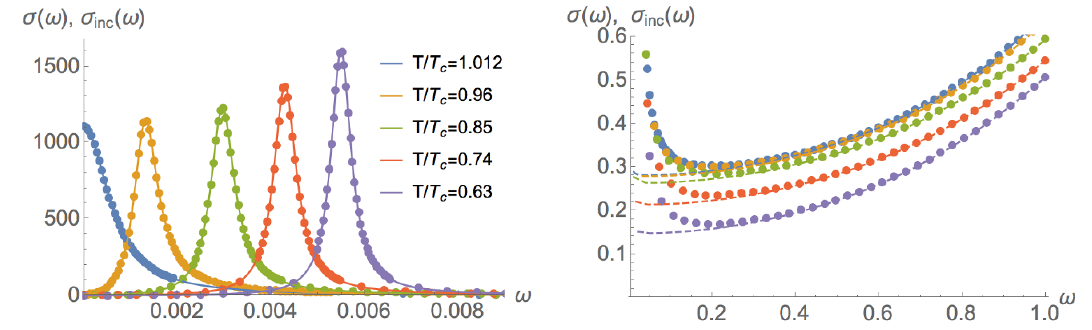
Figure 7 . AC optical and incoherent conductivities for the pinned spontaneous insulator (2.11) at selected values of the temperature. We show the optical values with dots, and the incoherent with a dashed line. The left panel zooms into the low frequency range, while the right panel show the high frequency results, one can see the right shoulders of the coherent peaks shown on the left panel, which arise in the low frequency region in the optical